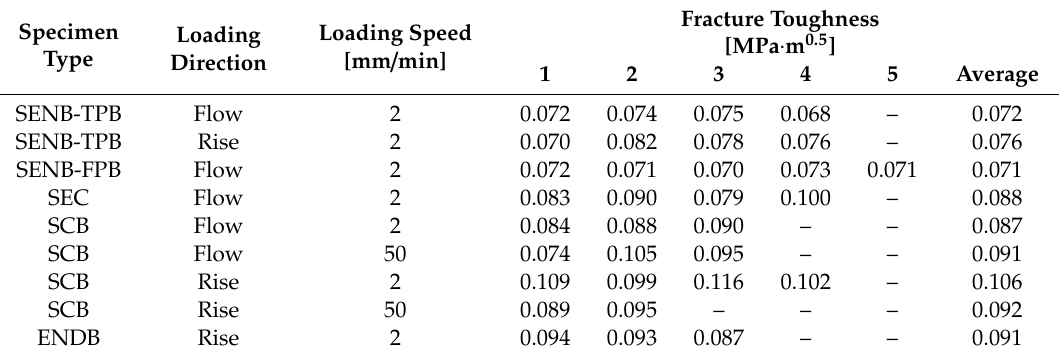
Table 2. Fracture toughness results for 100 kg / m 3 polyurethane (PUR) foam density.